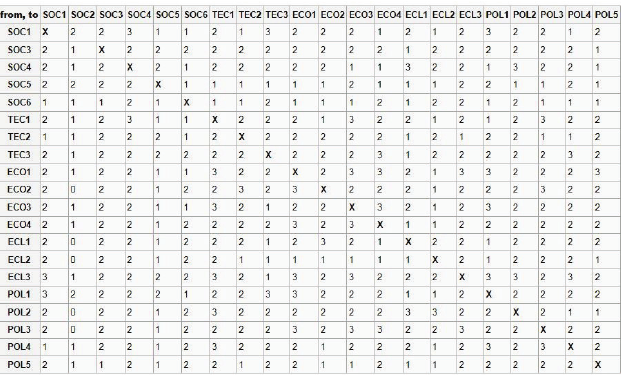
Fig. 3. Matrix of the influence between the factors of Teteven area.